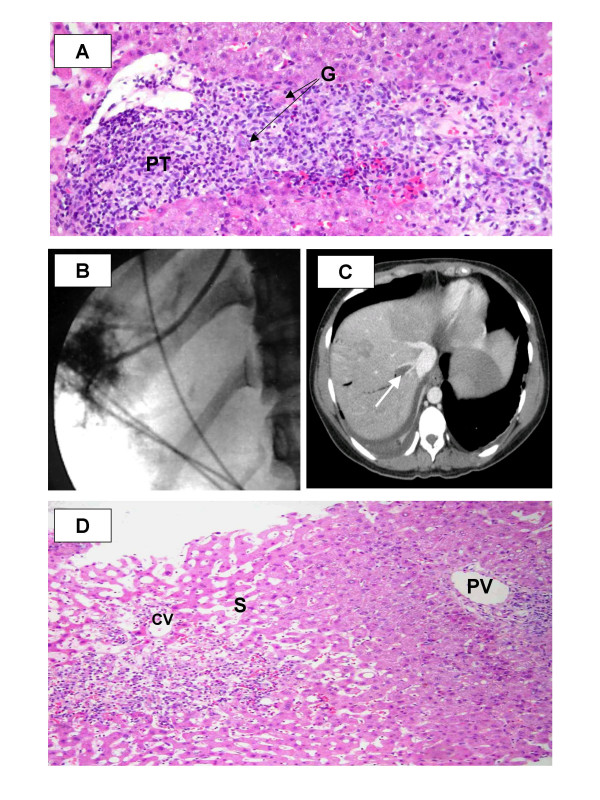
Panel A: Low magnification of the liver biopsy (HE 120 ×). The portal tract (PT) is infiltrated by a mixed inflammatory reaction. Microgranulomatous cell reaction (G) is visible. Panel B: Typical "spider-web" network pattern at hepatic angiography in the setting of partial Budd-Chiari syndrome. Panel C: Abdominal CT scan showing a fresh thrombus in the ostium of the right hepatic vein (arrow). Panel D: Low magnification of liver biopsy showing marked sinusoidal dilatation (S) and congestion around the central vein (CV). PV: portal vein.